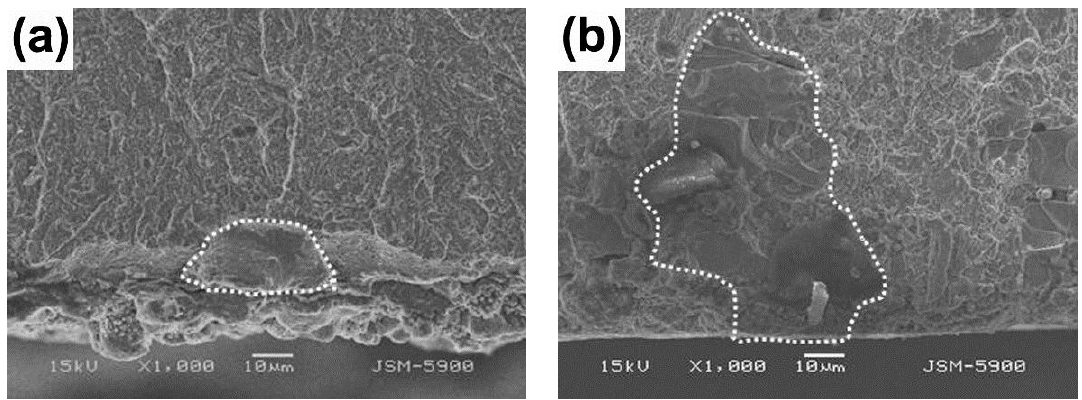
Figure 6. SEM images of fracture surface of the specimens after the Charpy impact test: ( a ) Cr6C9 and ( b ) STD11.